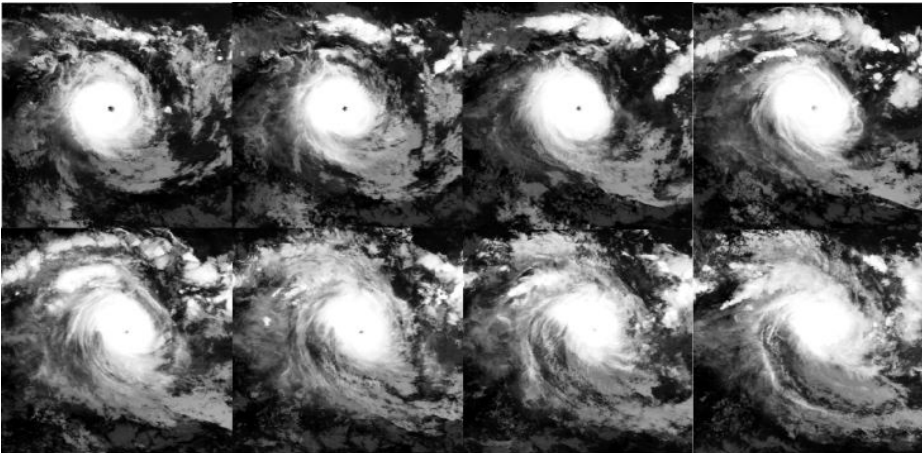
Figure 1. Gray-scale imagery of the Faraji cyclone, from 12.00 UTC on 8 February to 09.00 UTC on 9 February 2021, in 3-h